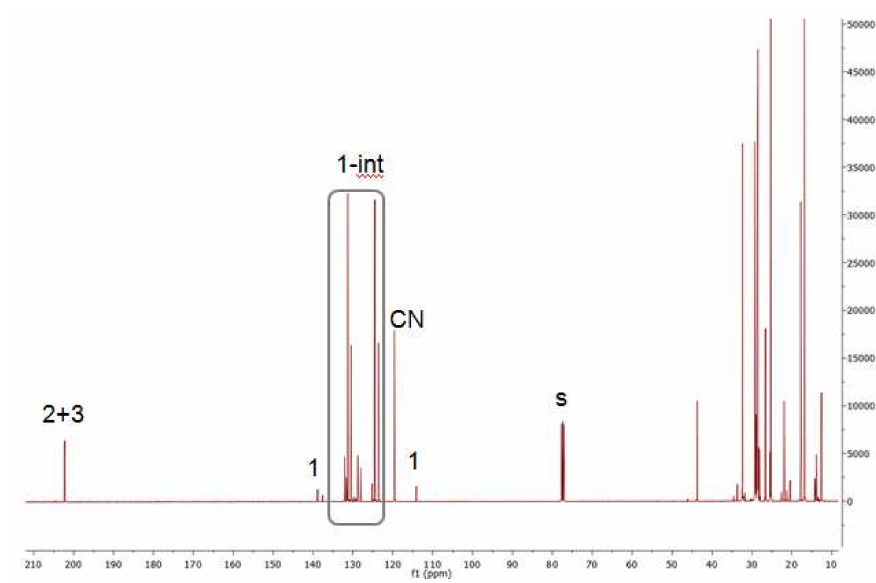
Figure A3. 13 C{ 1 H} NMR spectrum (100 MHz, CDCl 3 , 298 K) of a reaction mixture evidencing an “isomerization peak” (Table 2, entry 8). The important amount of internal olefins 1- int -x is easily